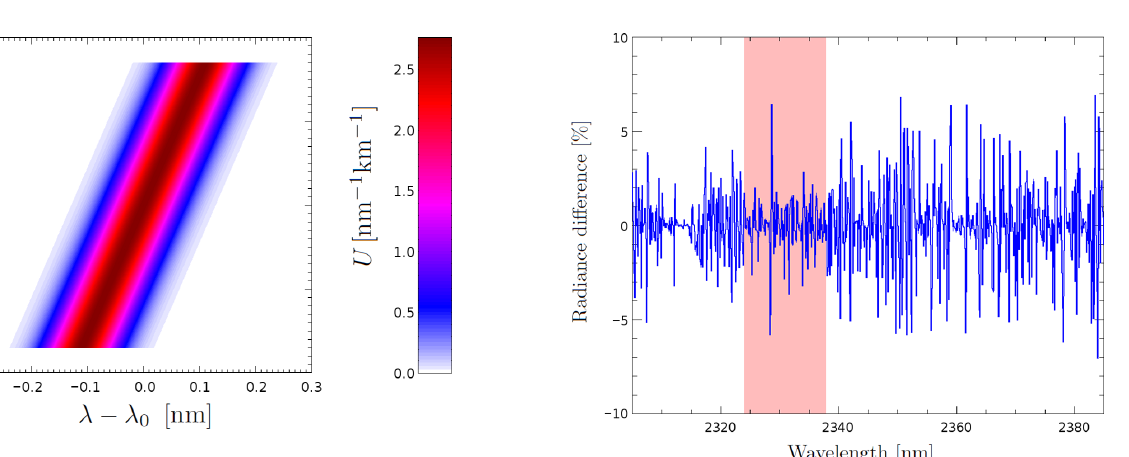
Figure B2. Instrument response function U(x 0 ,λ 0 | x,λ) as defined in Eqs. (B7) and (B8) with (cid:49)x = 3 . 4km, (cid:49)w = 0 . 1nm and b = 6 . 47 × 10 − 2 nmkm − 1 .